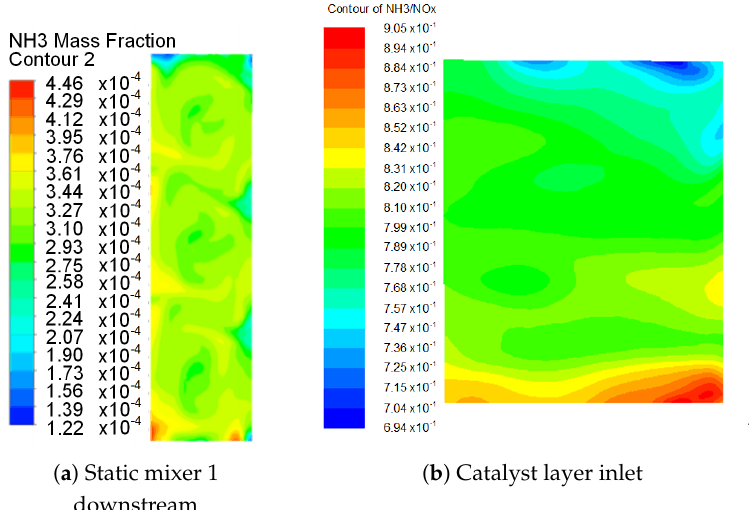
Figure 8. Concentration field with static mixer 1. ( a ): Distribution diagram of ammonia concentration in the downstream section of static mixer. ( b ): Distribution diagram of ammonia nitrogen mole ratio of section in front of the catalyst layer.